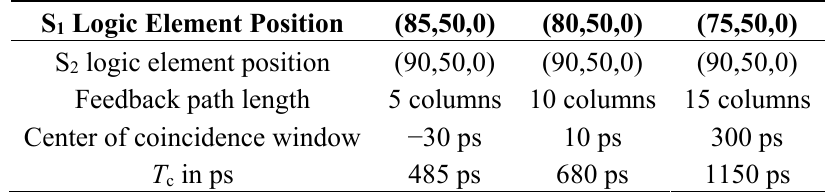
Table 3. Coincidence window T c depending on the distance between the CDL’s logic